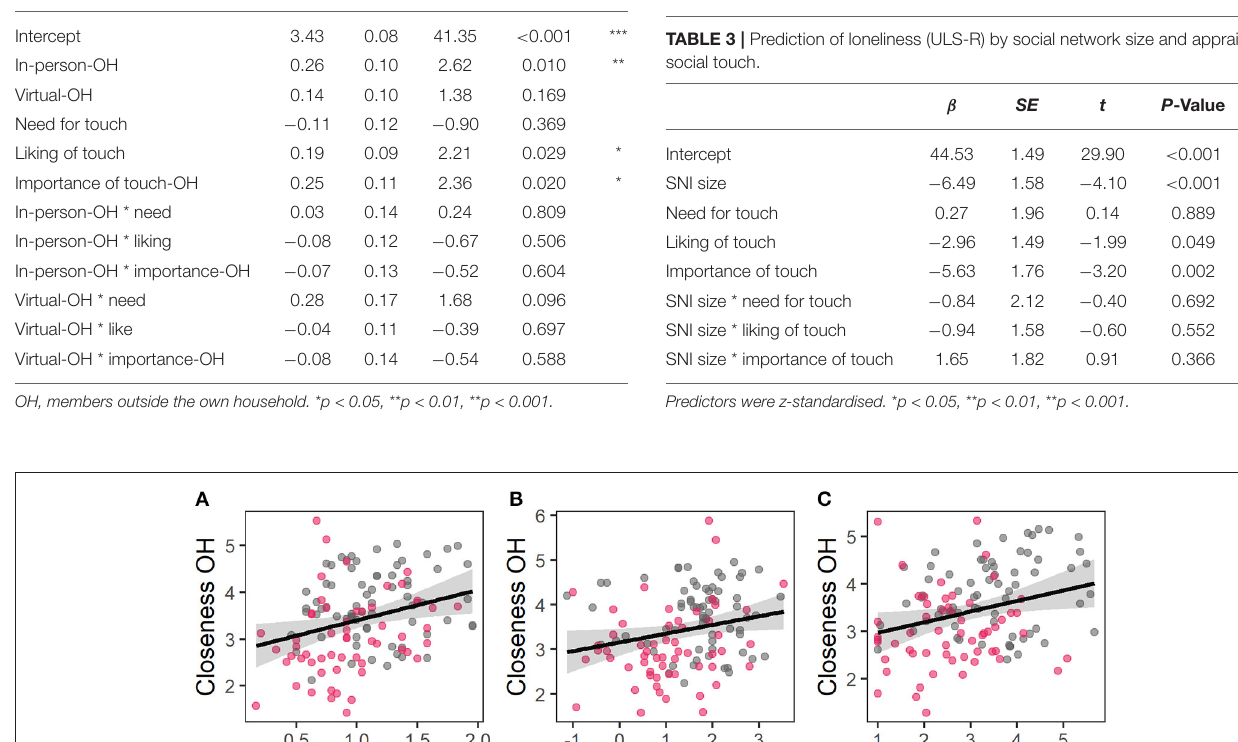
Frontiers in Psychiatry |